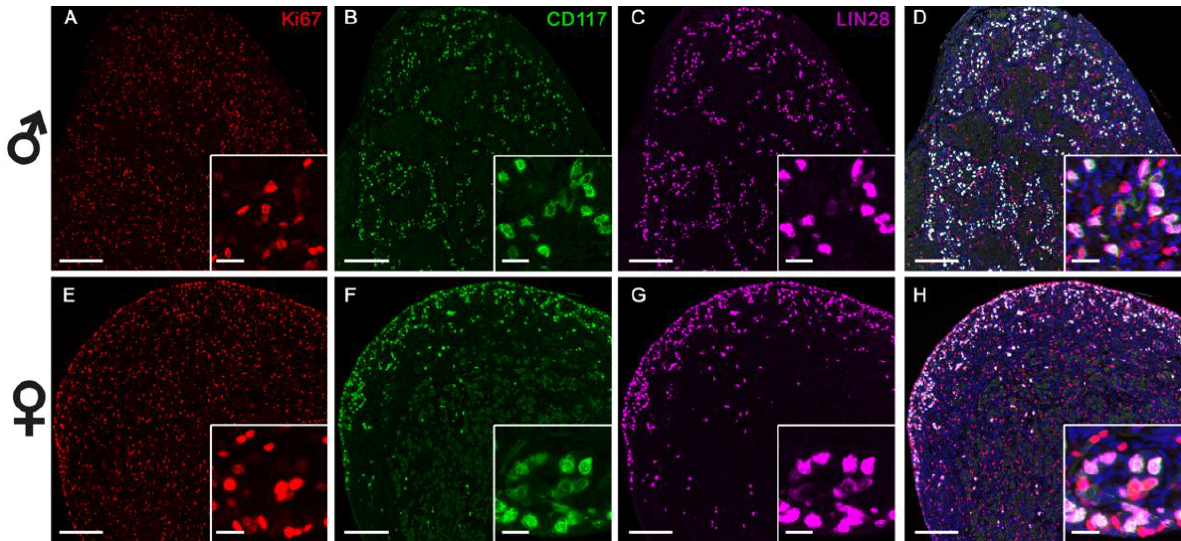
Figure 7. Triple immunofluorescence staining of fetal male ( A – D ) and female ( E – H ) horse gonads at 60 days of gestation. Proliferation marker Ki67 (red) is present throughout the gonad in both sexes and has a different localization than LIN28 and CD117. A distinct staining pattern depending on sex is observed for CD117 (green) and LIN28 (pink): in male gonads, CD117 and LIN28 are scattered throughout the gonad, while in females they are mainly localized at the periphery of the gonad. Scale bar: 100 µm for large pictures, 25 µm for the inserts. Blue staining denotes cell nuclei. Table 2. Percentiles of immunofluorescent staining in gonads of horse fetuses at 60 days of gestation for single markers (Ki67, CD117, and LIN28) and respective co-localization of two markers. Ki67